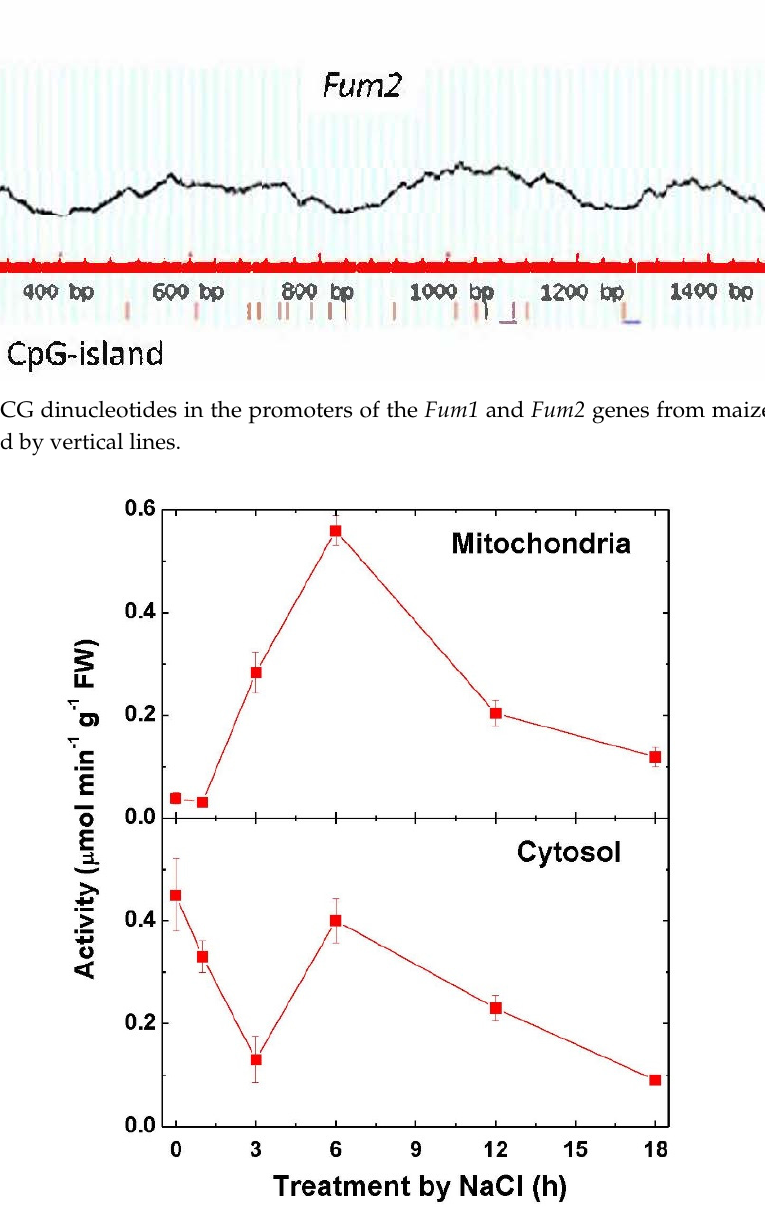
Figure 1. Analysis of CG dinucleotides in the promoters of the Fum1 and Fum2 genes from maize. The position of CG nucleotides is indicated by vertical lines.